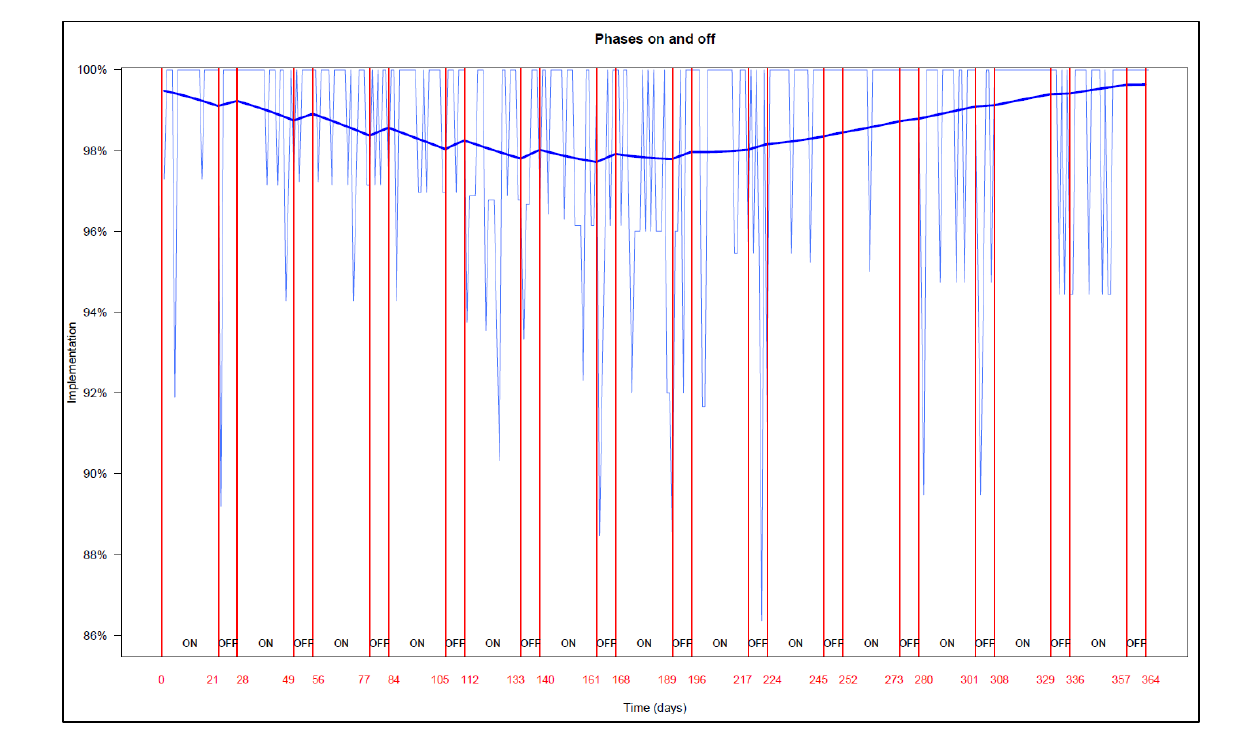
Figure A1. NB: The end of each ON (21 days) and OFF phase (7 days) is represented in red lines and numbers. Empirical implementation is represented with the light blue curves, GEE modelisation is represented with the thick blue curve in each ON and OFF phase.